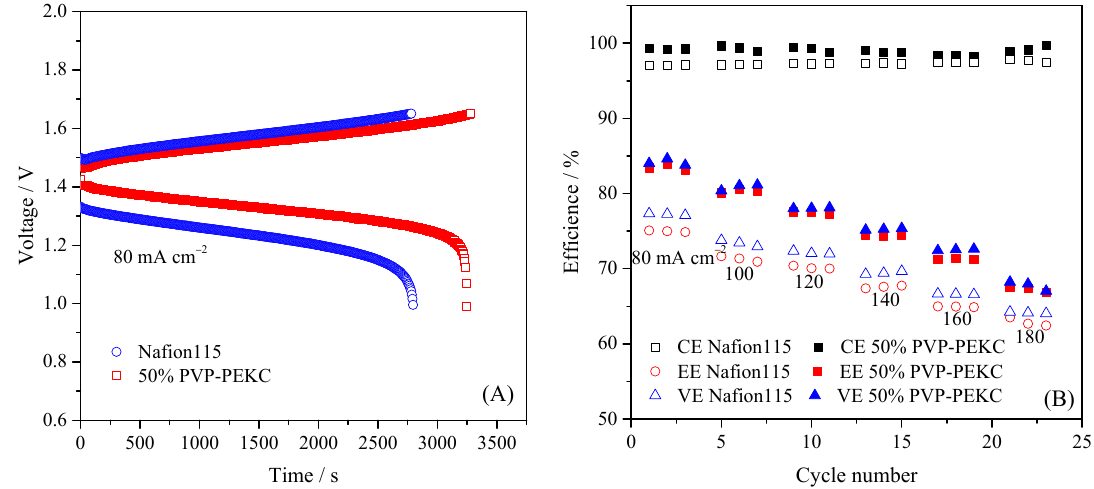
Figure 10. ( A ) Charge–discharge curves of batteries with 50%PVP-PEKC and Nafion115 membranes at 80 mA cm − 2 ; ( B ) battery performance of CE, VE and EE at different current densities. Figure 10B depicts the CE, VE and EE of − VRFBs equipped with 50%PVP-PEKC and Nafion115 at 80–180 mA cm − 2 . The CEs (~99%) of 50%PVP-PEKC membrane were higher than that of Nafion115 (~97%) due to its low vanadium ion permeability. It is not arduous